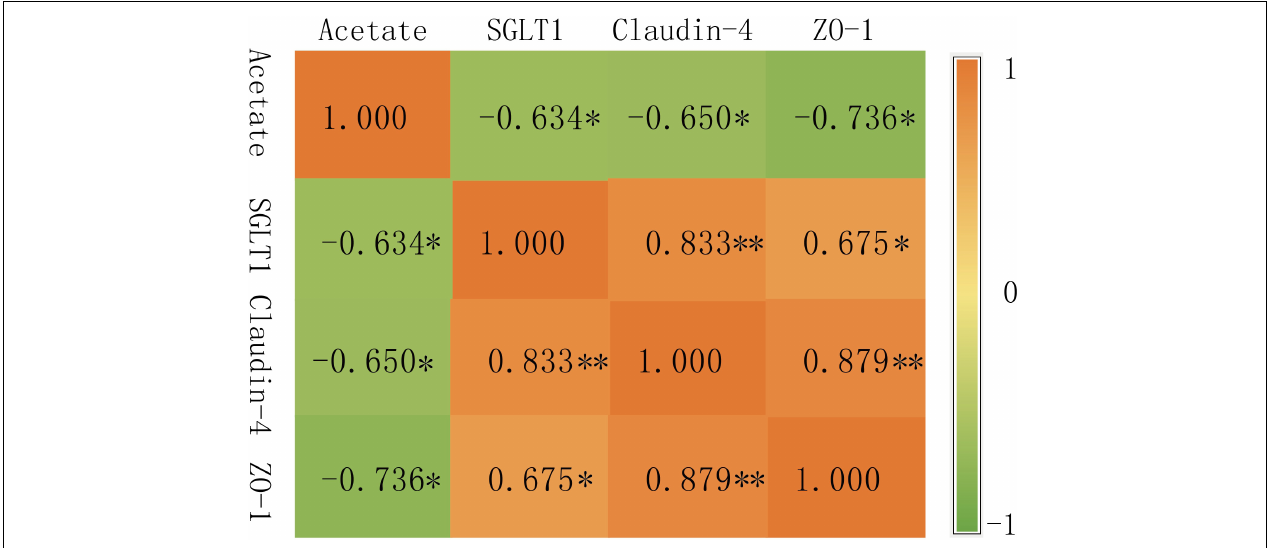
FIGURE 7 | Correlation between genes. ∗ At the 0.05 level (two-tailed), the correlation is significant; ∗∗ At the 0.01 level (two-tailed), the correlation is significant.